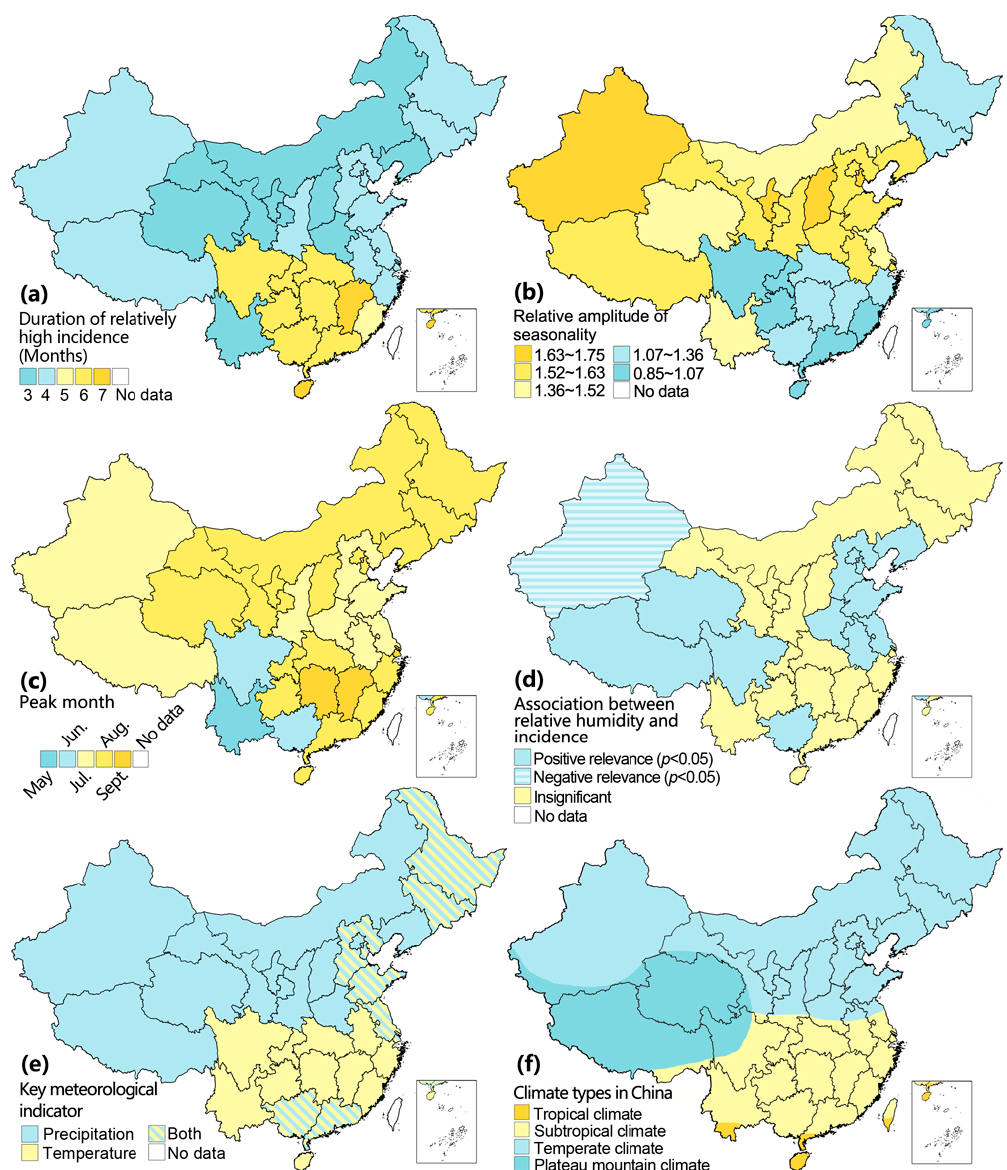
Figure 2. Seasonality of bacillary dysentery incidence and meteorological factors in each province: ( a ) peak duration, number of months with a higher incidence than half of peak incidence; ( b ) relative amplitude, ratio of peak and bottom incidence; ( c ) peak month; ( d ) association between relative humidity and incidence; ( e ) key meteorological indicator; ( f ) climate types in China [34]. The maps were created using the ArcGIS 10.0 software (ESRI Inc.).